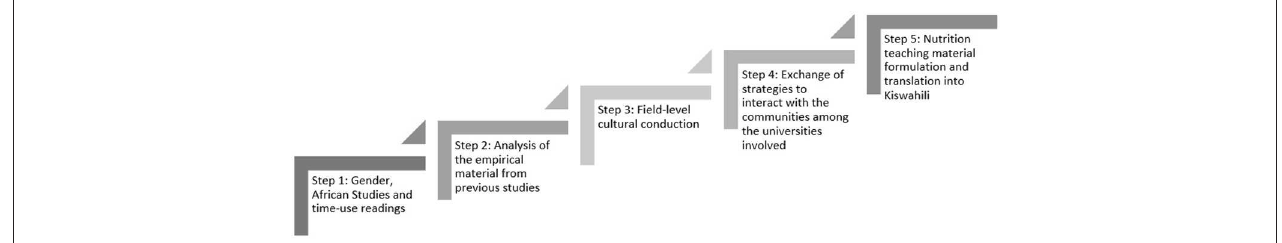
FIGURE 2 | Pre-fieldwork activities timeline. Source: Author’s own elaboration.